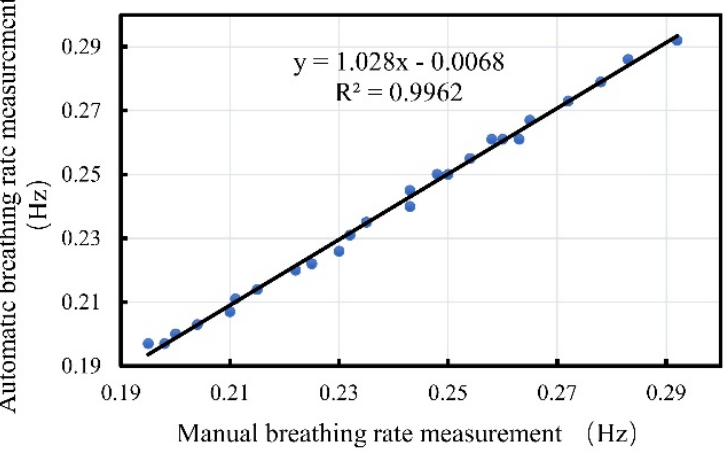
Figure 5. Comparison of the effects of manual observation and the NDBRMS system for measuring breathing rate.